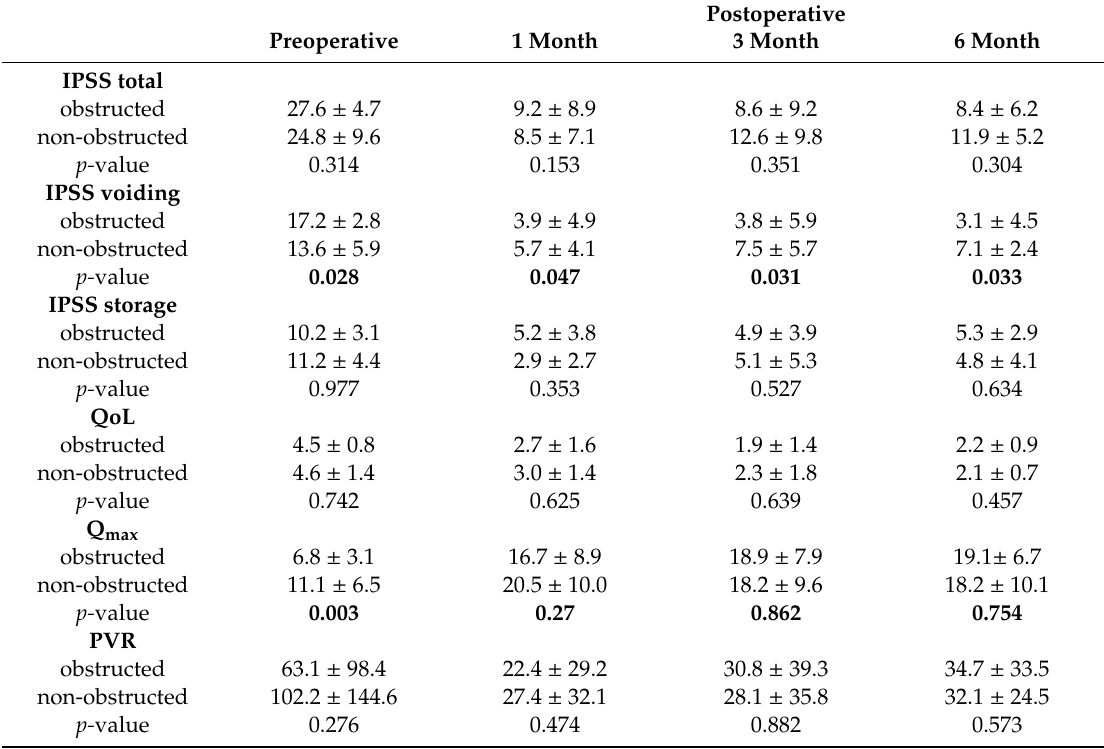
Table 3. A comparison of follow-up data from cases identified as obstructed or non-obstructed by the penile cu ff